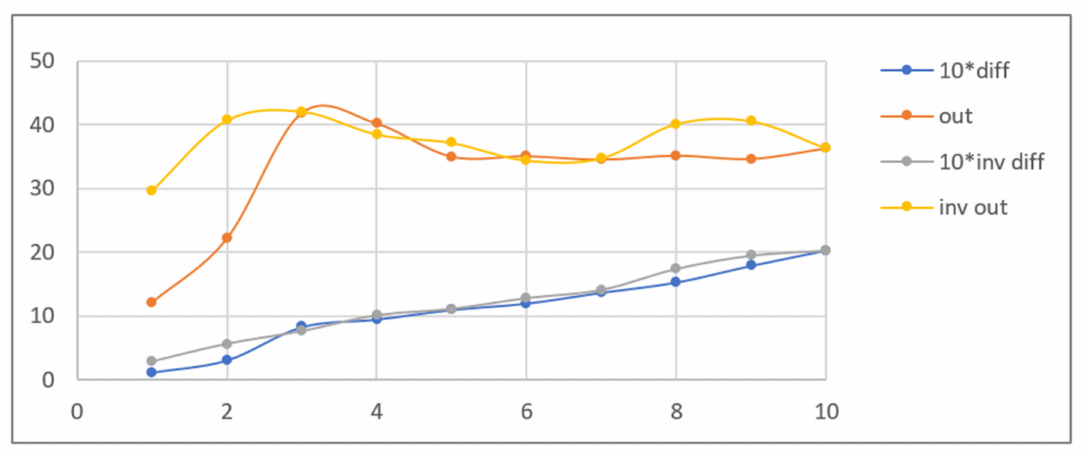
Figure 10. Results of simulation with ID card images for increasing UV light share (1 ÷ 10%) and the ambient light image as a reference (0–1%, 0–2%, 0–3%, etc.), and using pairs of composite images with increasing share difference (9–10%, 8–10%, 7–10%, etc.)—average brightness of the differential image (scaled × 10 for legibility) and output image vs. UV share difference